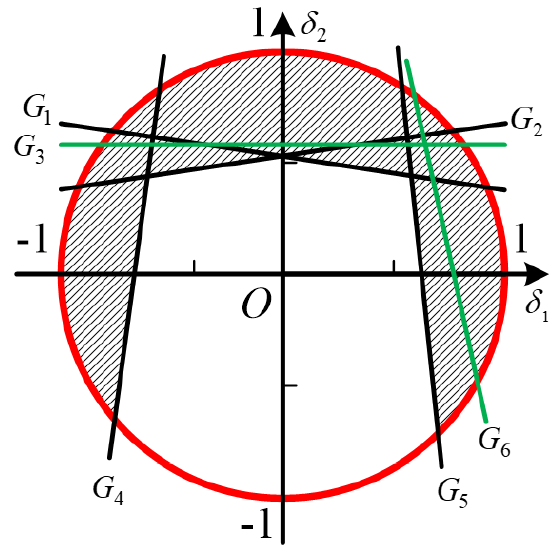
Figure 5. Six failure modes for numerical example 1. Table 2. Identification criteria and redundant failure modes for numerical example 1.